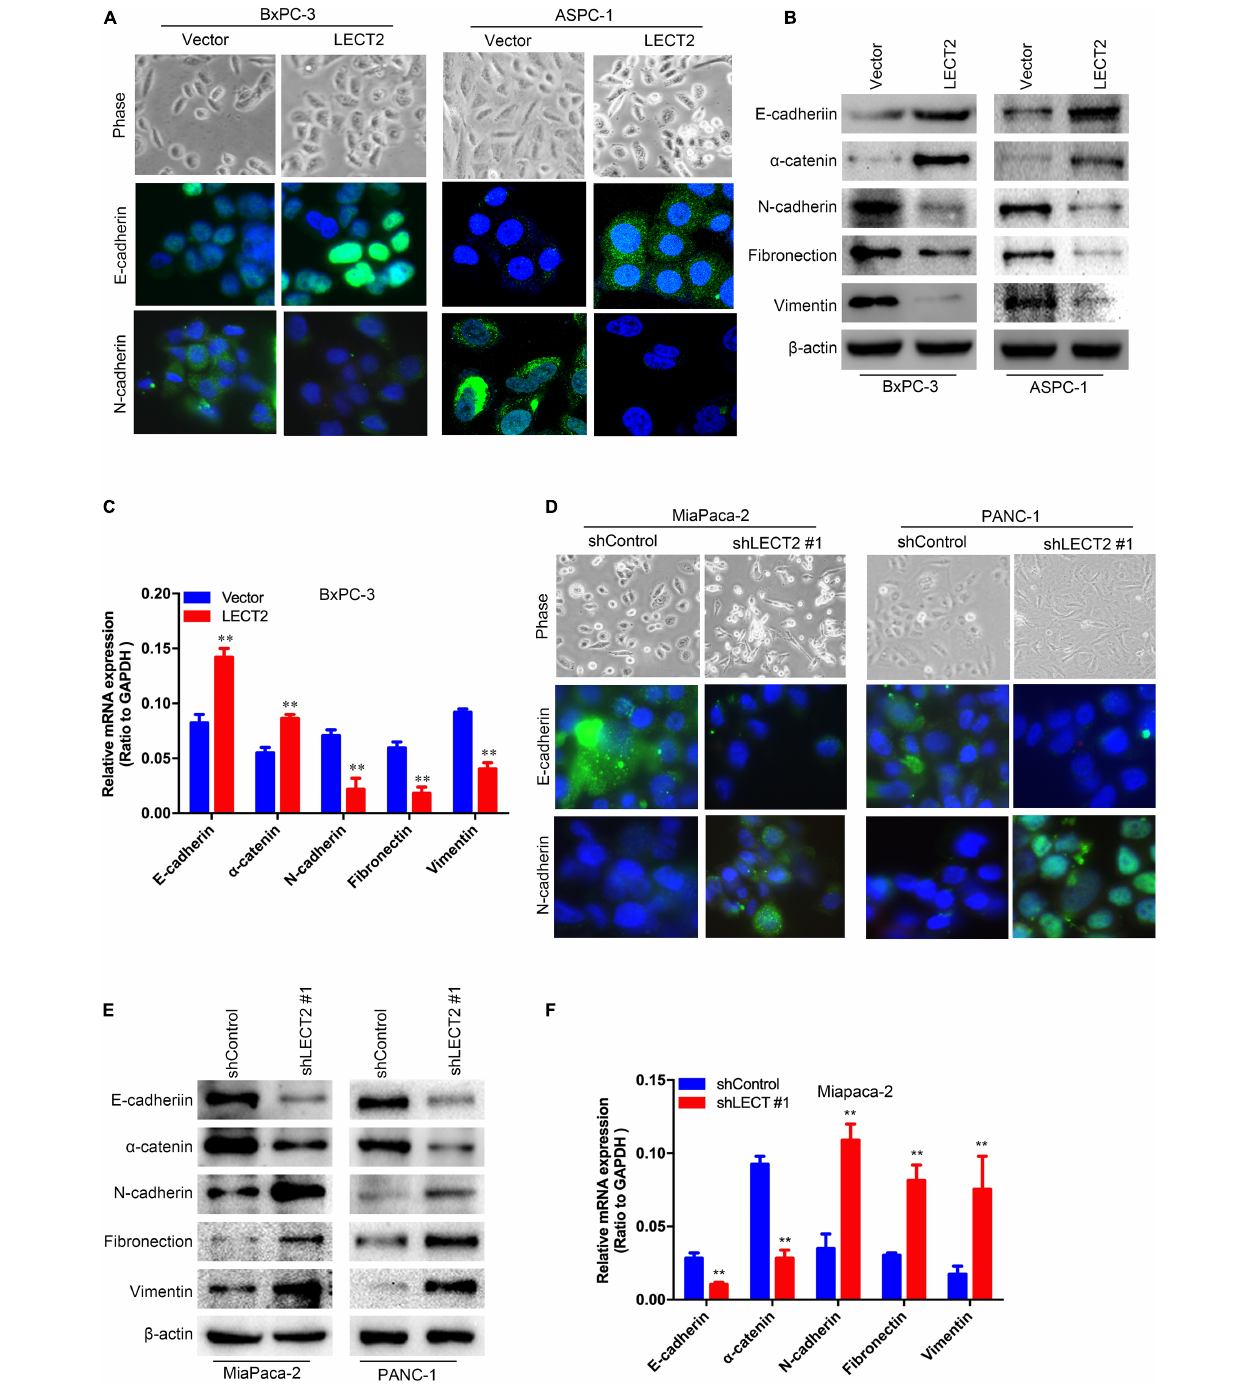
FIGURE 3 | LECT2 inhibits epithelial-mesenchymal transition (EMT) in PDAC. (A) Phase-contrast images (top) and immunofluorescence images of transformed BxPC-3 (left) and ASPC-1 (right) cells stained with antibodies against E-cadherin (middle), or N-cadherin (bottom panel). BxPC-3 and ASPC-1 cells were transfected with control or LECT2 vector, as described in Figure 2 . (B) Immunoblotting analysis of expression of E-cadherin, α -catenin, N-cadherin, Fibronectin, and Vimentin proteins in the cells shown in (A) . β -actin was used as a loading control. (C) mRNA expression of E-cadherin, α -catenin, N-cadherin, Fibronectin, and Vimentin in transformed BxPC-3 cells as described above. (D) Phase-contrast images (top) and immunofluorescence images of transformed MiaPaca-2 (left) and Panc-1 (right) cells stained with antibodies against E-cadherin (middle), or N-cadherin (bottom panel). MiaPaca-2 and Panc-1 cells were transfected with shControl or shLECT2 vector, as described in Figure 2 . (E) Immunoblotting analysis of expression of E-cadherin, α -catenin, N-cadherin, Fibronectin, and Vimentin proteins in the cells shown in (D) . β -actin was used as a loading control. (F) mRNA expression of E-cadherin, α -catenin, N-cadherin, Fibronectin, and Vimentin in transformed MiaPaca-2 cells as described above. Scale bar = 20 µ m in (A) and (D) . ** p < 0 . 01.